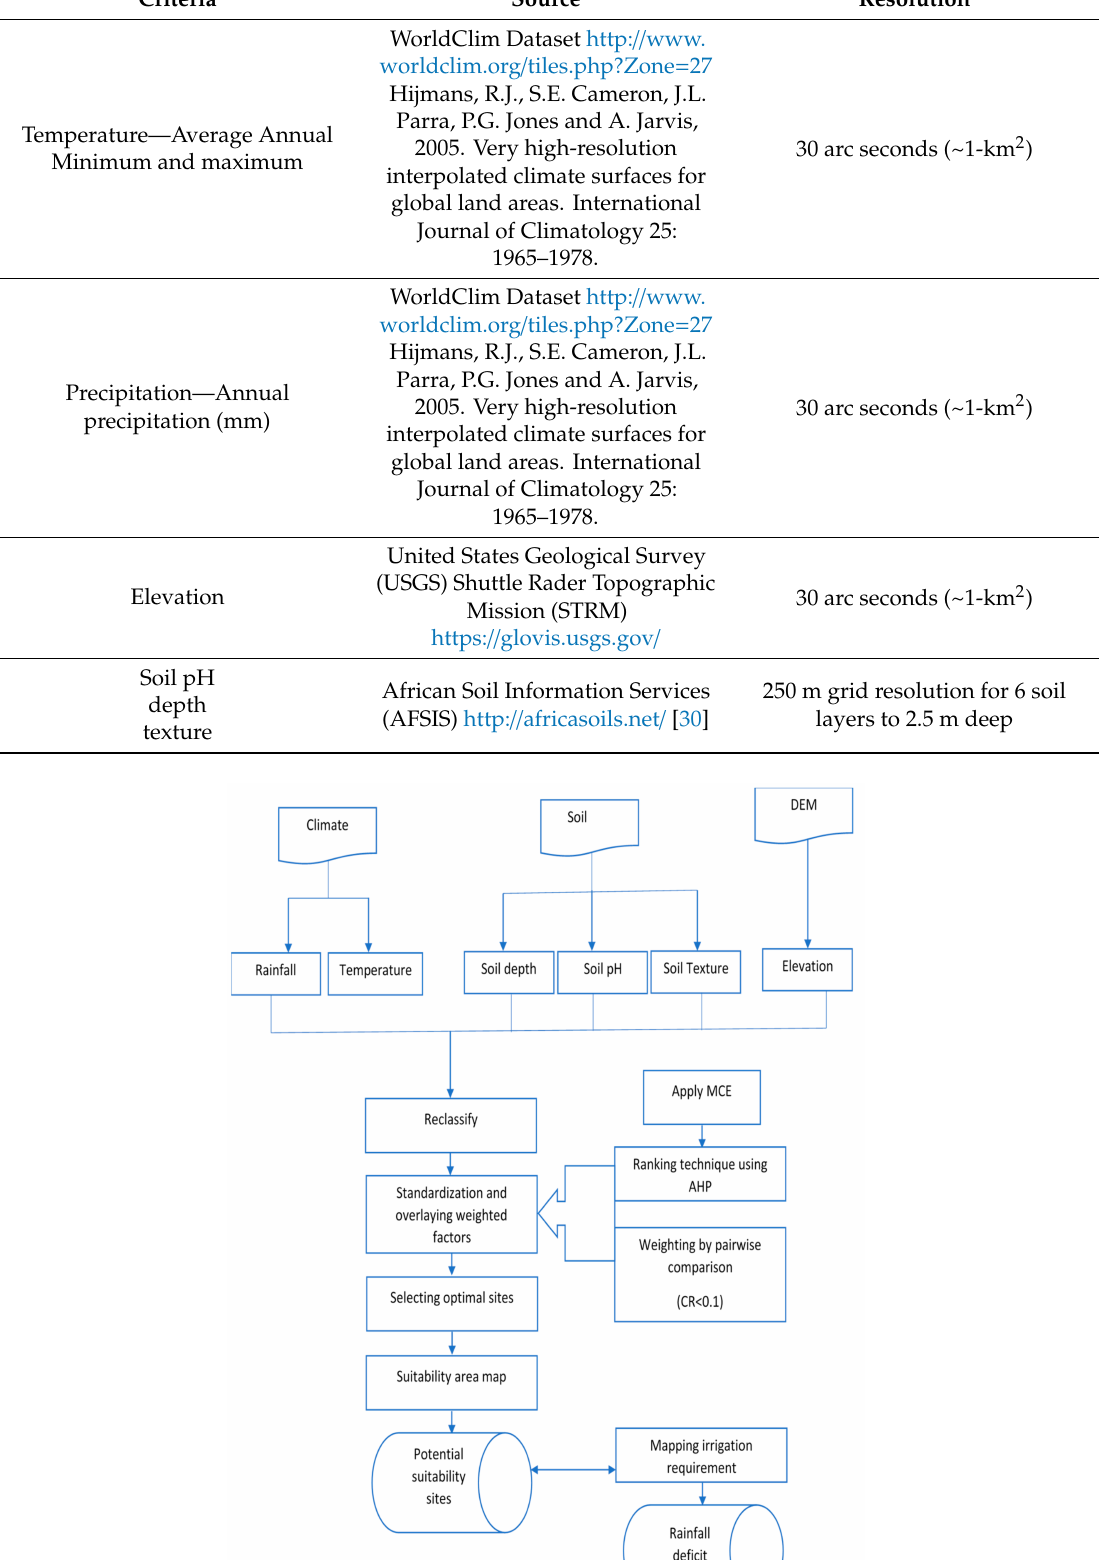
Table 1. Data used for the land suitability analysis.